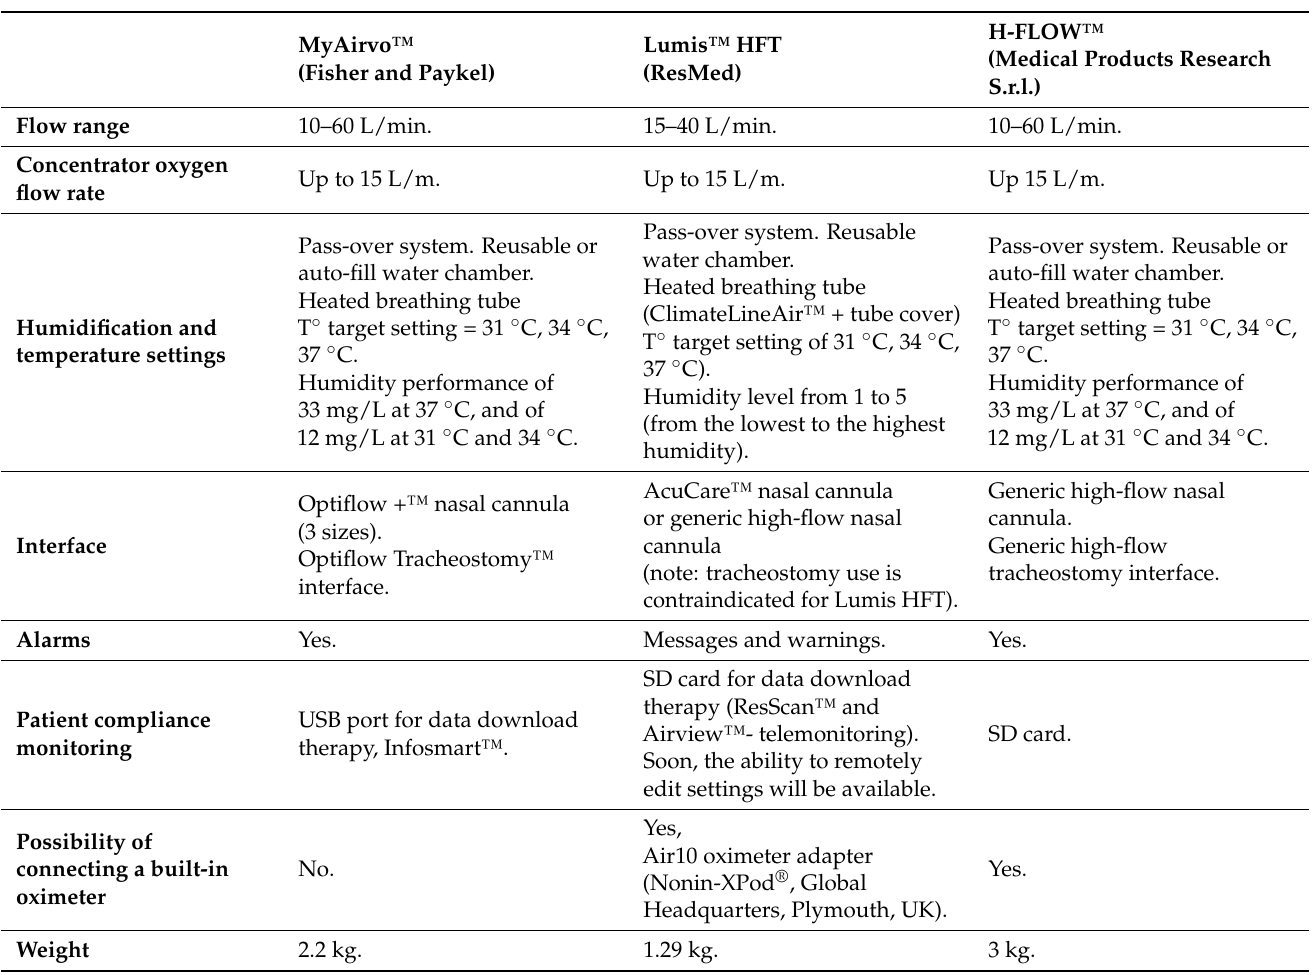
Table 3. Main characteristics of HHFT